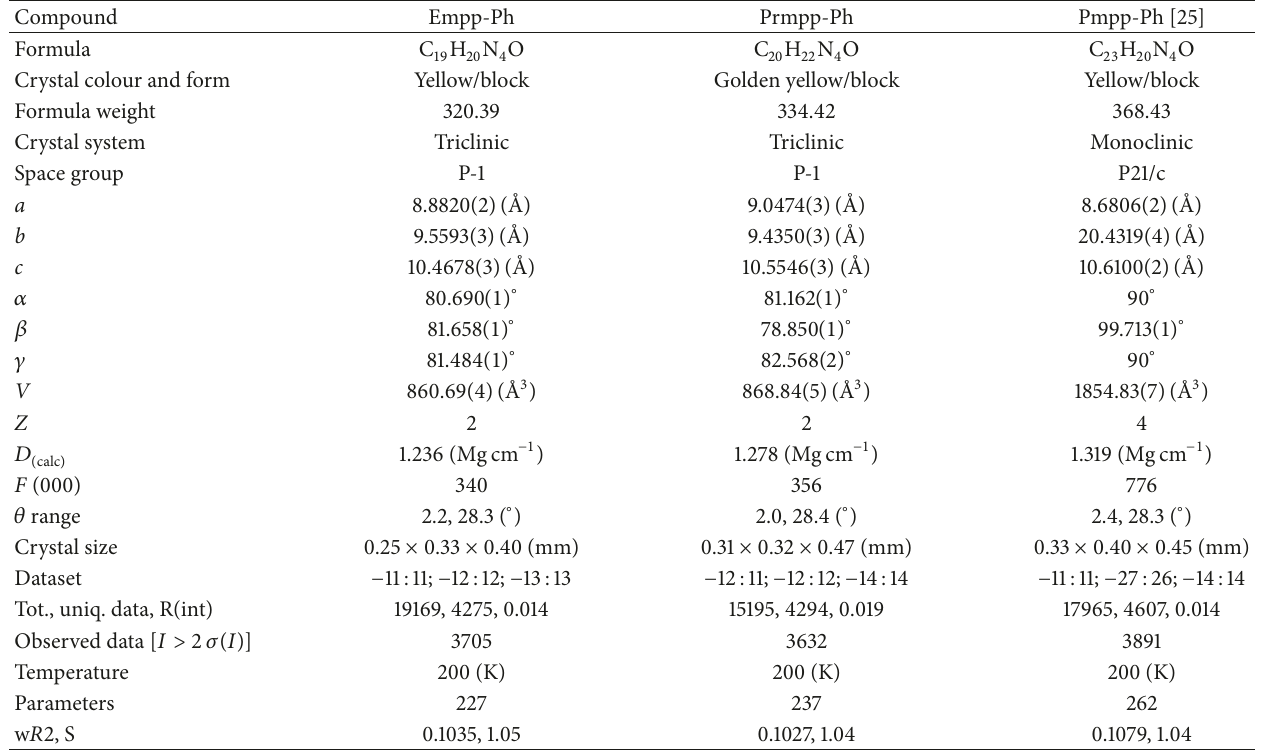
Table 1: Crystallographic data for Empp-Ph and Prmpp-Ph.